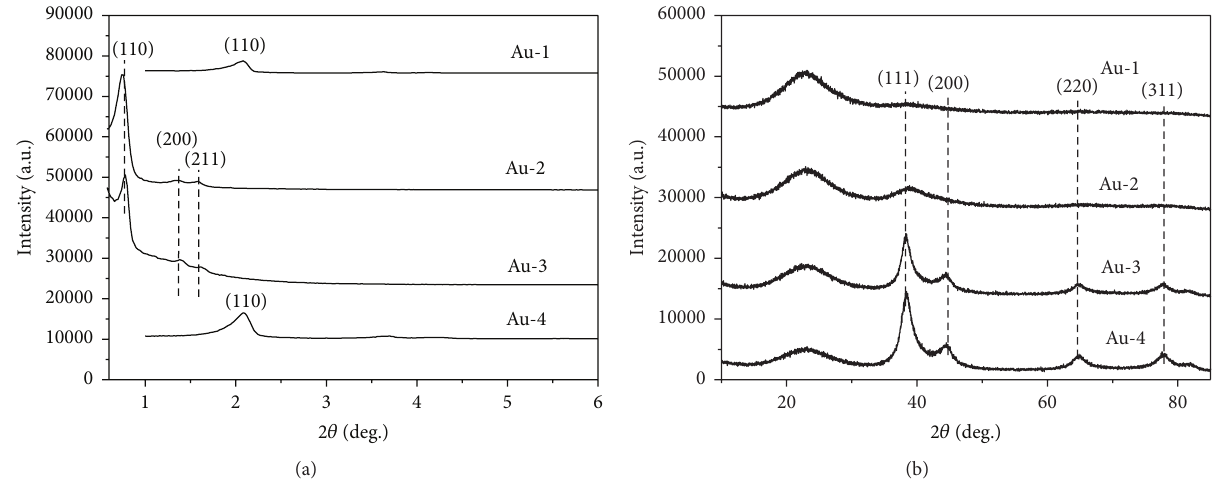
Figure 1: (a) Small- and (b) wide-angle XRD patterns of various Au nanoparticles supported mesoporous silica